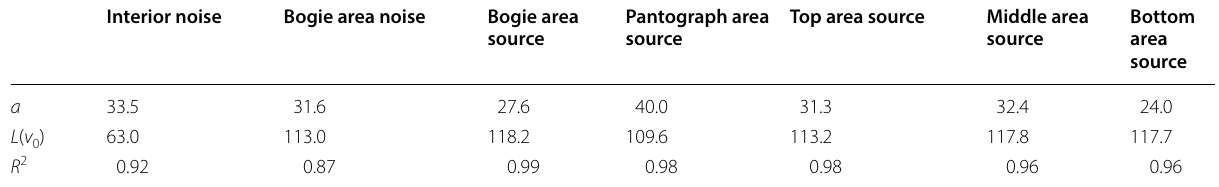
Table 1 Fitting results for the exterior and interior noises at different speeds